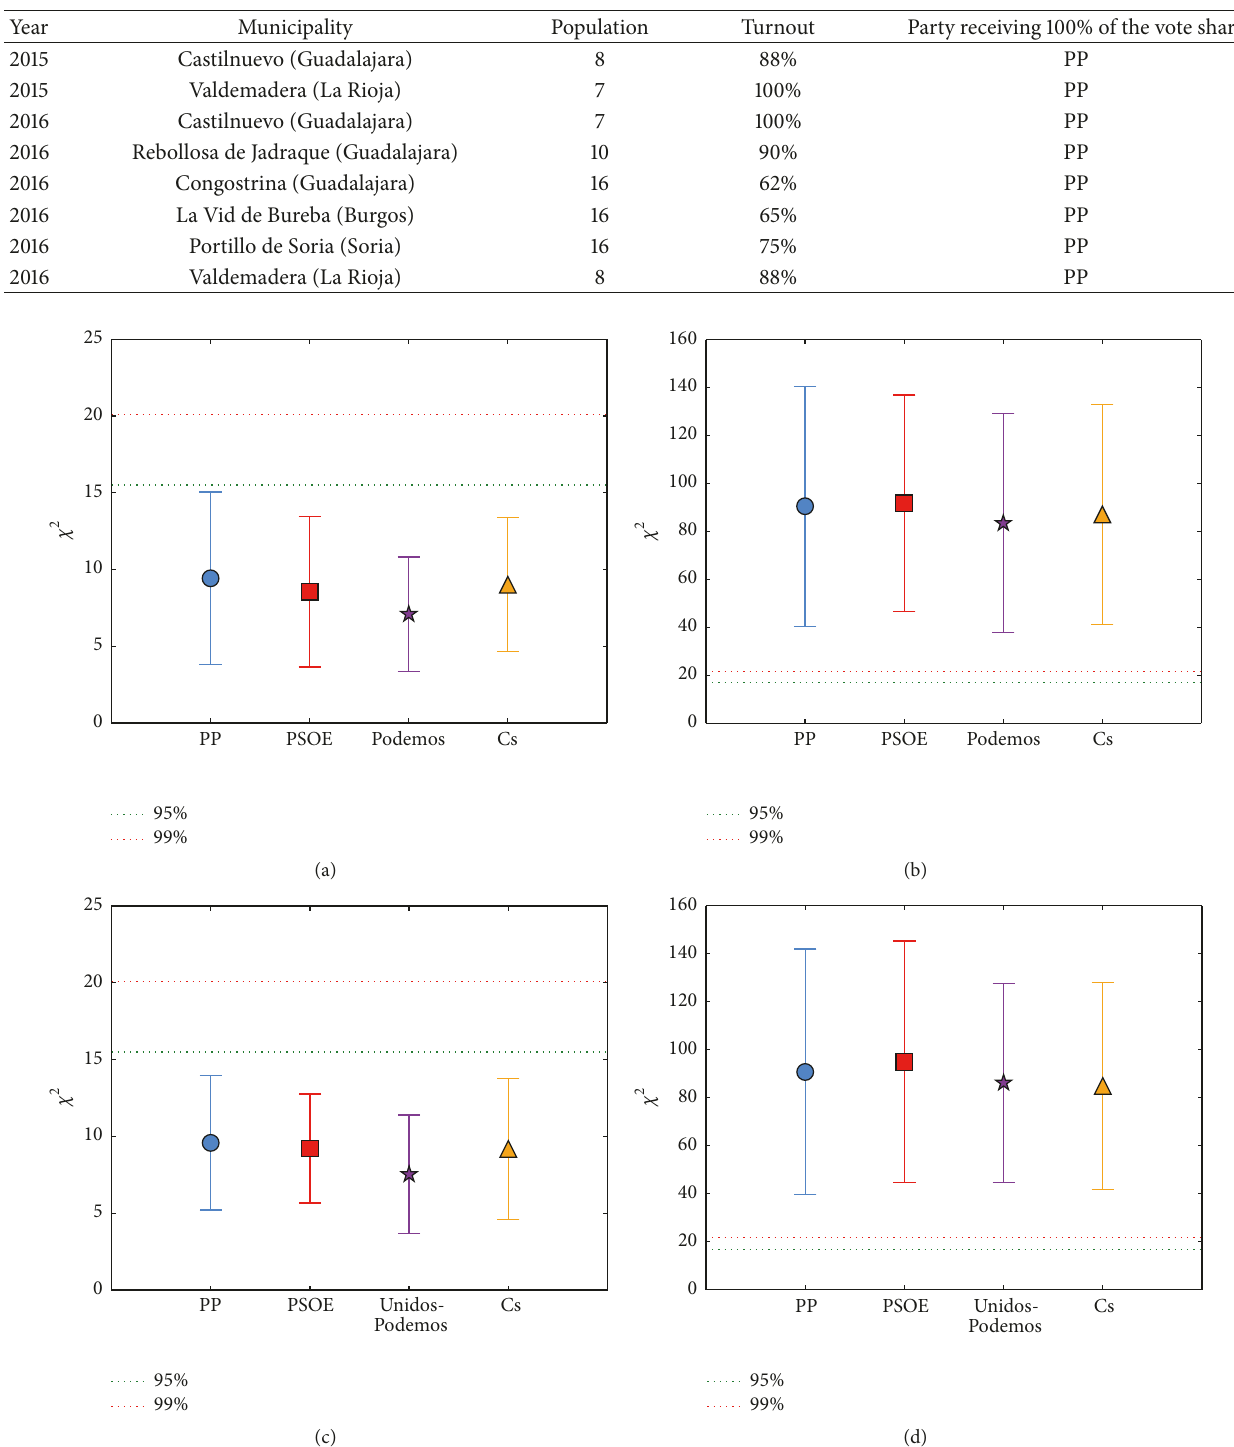
Table 4: List of municipalities where a single party receives 100% of the vote share.